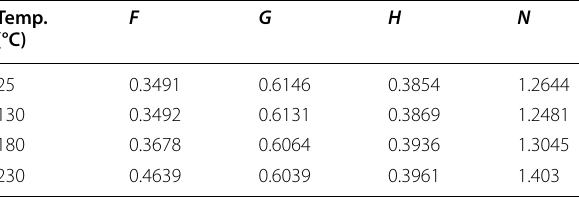
Table 4 Identified parameters in the Hill48 yield function Temp. (°C)